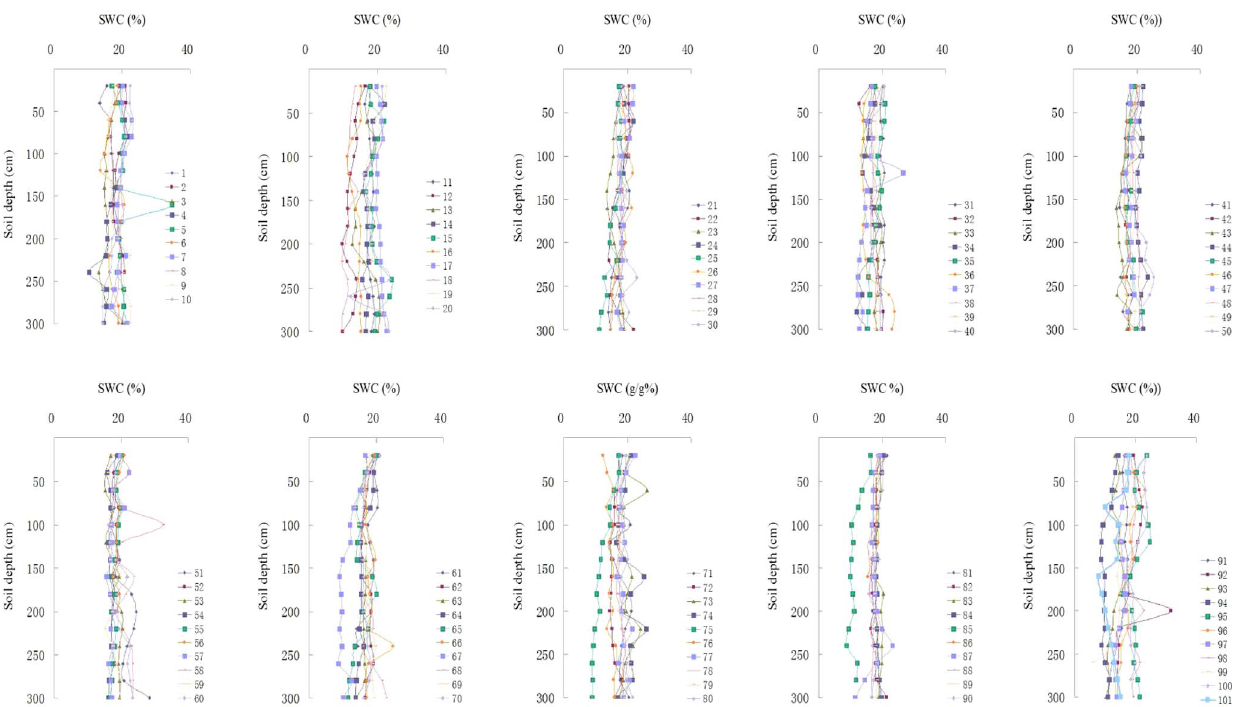
Figure 3. Vertical profiles of soil water at 101 sampling points in the Sanyanjing catchment.